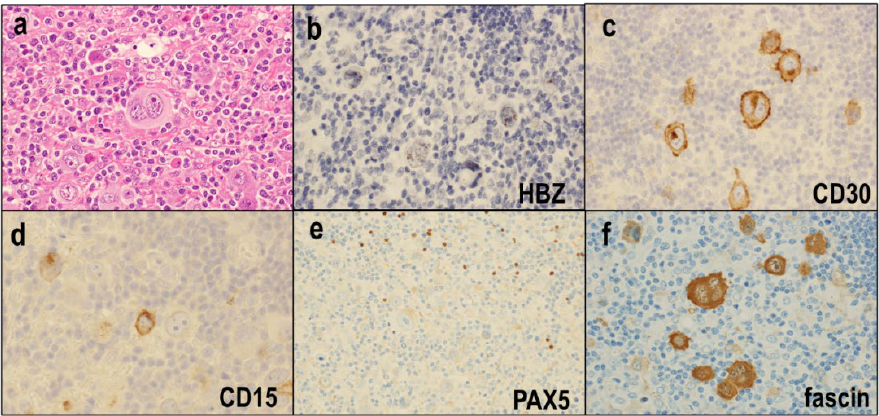
Figure 8. Adult T-cell leukemia/lymphoma with HTLV-1-infected HRS-like cells (ATLL-HH). ( a ) Scattered HRS-like cells are intermingled with abundant inflammatory cells (×400). ( b ) The HRS-like cells of ATLL-HH are infected by HTLV-1. ( c – e ) The HRS-like cells show positive staining for CD30 (×400) and CD15 (×400) and are negative for B-cell markers (PAX5 × 400). ( f ) The HRS-like cells are frequently positive for fascin (×400).